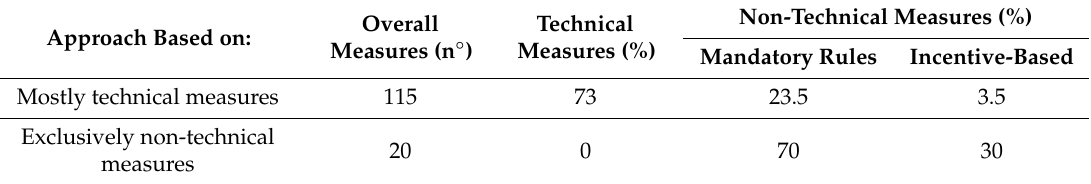
Table 1. Different approaches adopted by the regions for the selection of irrigation water efficiency measures. Table 1. Di ff erent approaches adopted by the regions for the selection of irrigation water e ffi ciency measures.